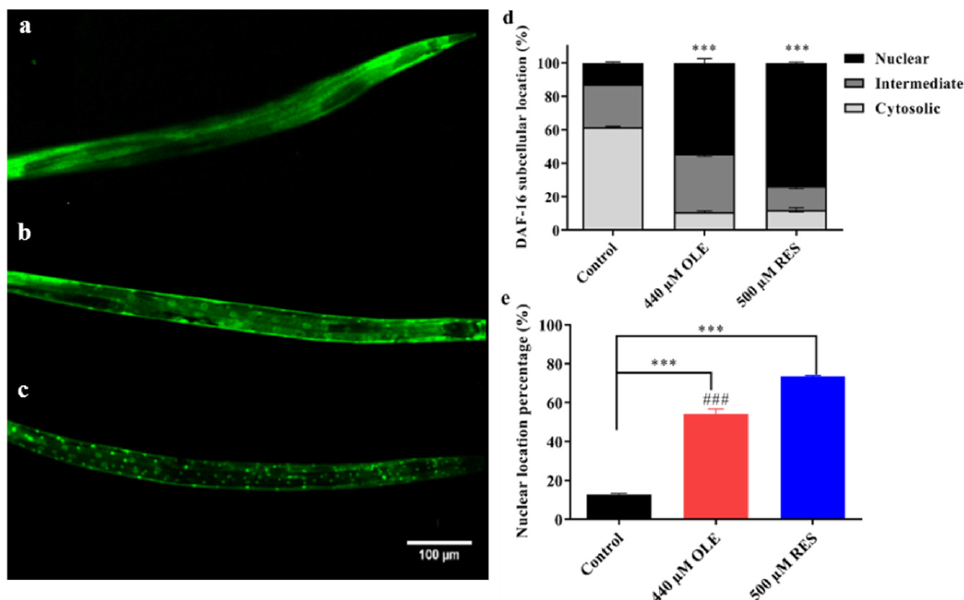
Figure 8. Effect of OLE on the subcellular localization of DAF-16::GFP. ( a ) Cytosolic translocation; ( b ) Intermediate translocation; ( c ) Nuclear translocation; ( d ) Influence of OLE on the localization of DAF-16::GFP. The histogram represents the fraction of TJ356 worms number with cytosolic, intermediate, or nuclear localization of DAF-16::GFP; ( e ) OLE significantly induced the nuclear translocation of DAF-16::GFP. *** p < 0.001 suggests a significant difference when compared to the control group, while ### p < 0.001 suggests a significant difference when compared OLE with the RES group.